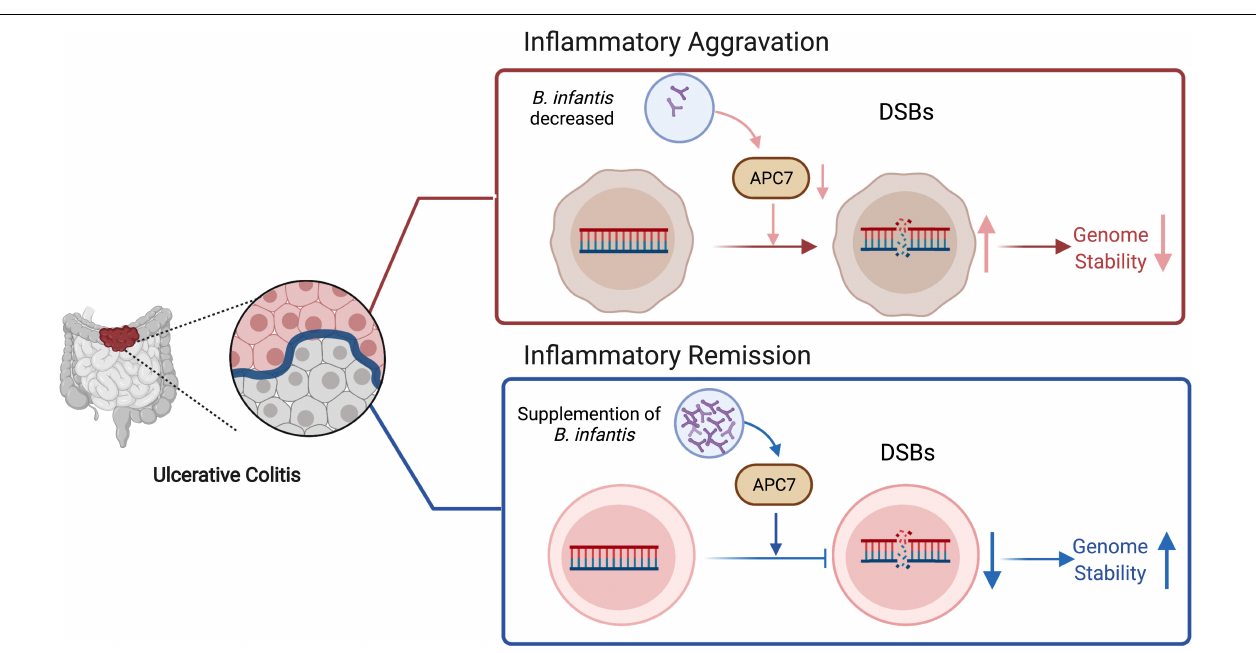
Frontiers in Microbiology |